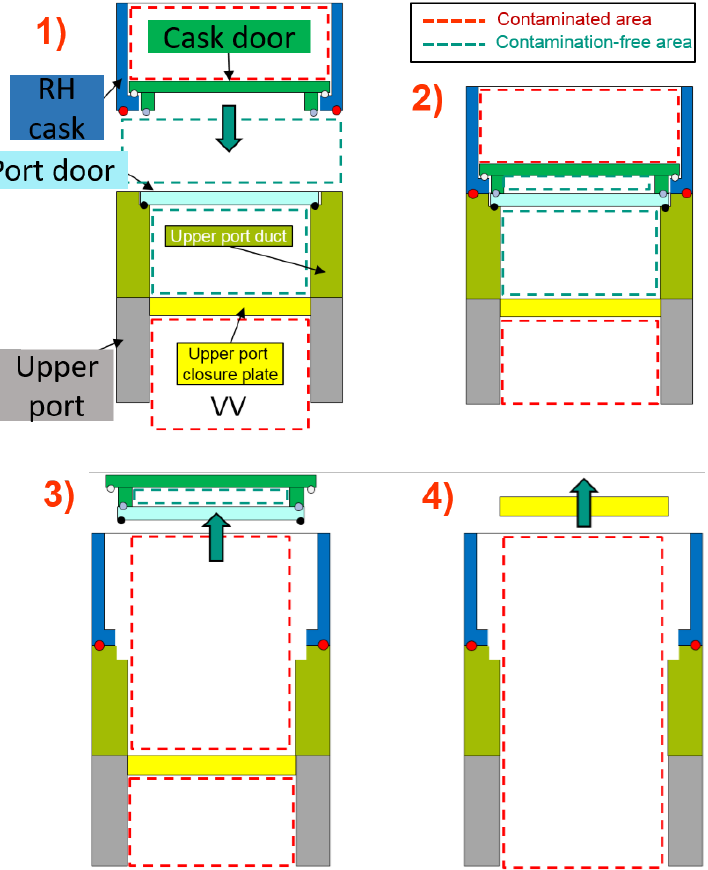
Figure 10. The main sequence of opening the CCD. Step ( 1 ): RH cask docks with the port; step ( 2 ): Cask door and port door are connected; step ( 3 ): CCD is lifted; step ( 4 ): Port closure plate is removed.